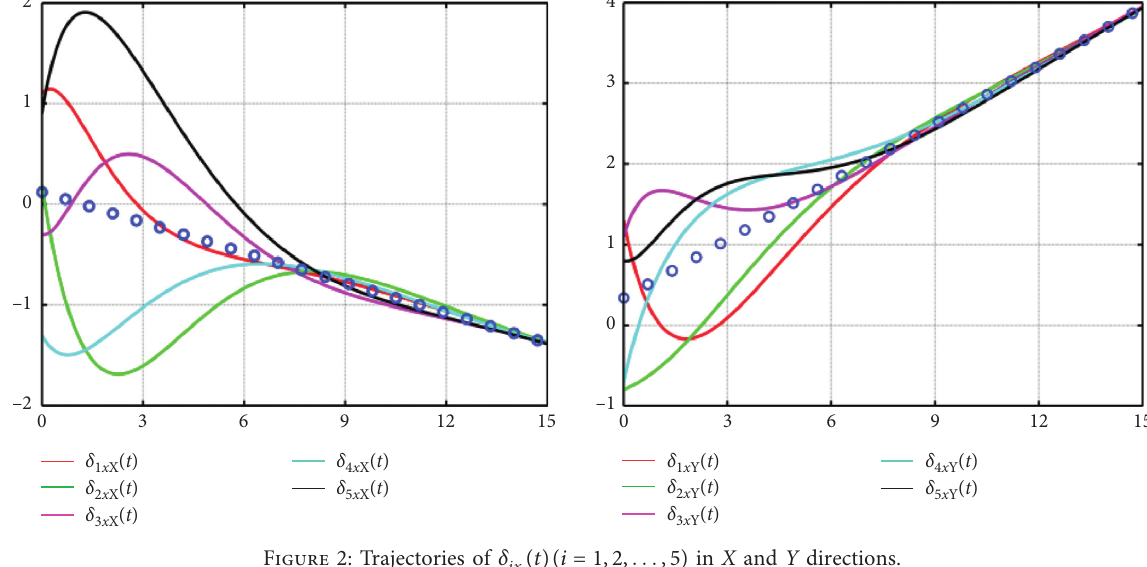
( t )( i � 1 , 2 , .. . , 5 ) in X and Y directions. ix